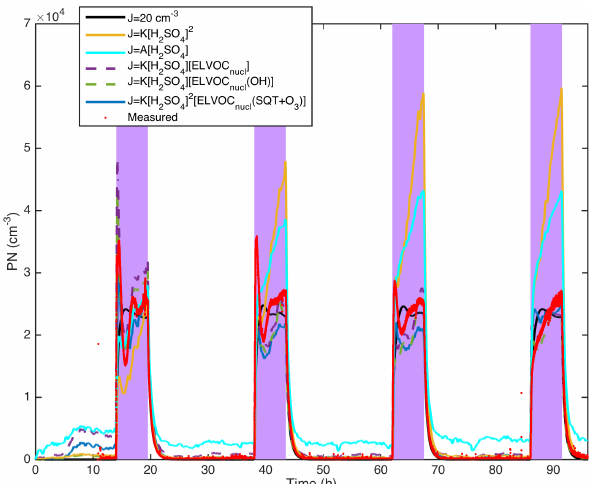
Figure 11. Measured (PSM-CPC) and modelled total particle num- ber concentration with different nano-CN formation mechanism. The SOA formation was modelled with the 2-D VBS approach in- cluding ELVOC formation (Reactions